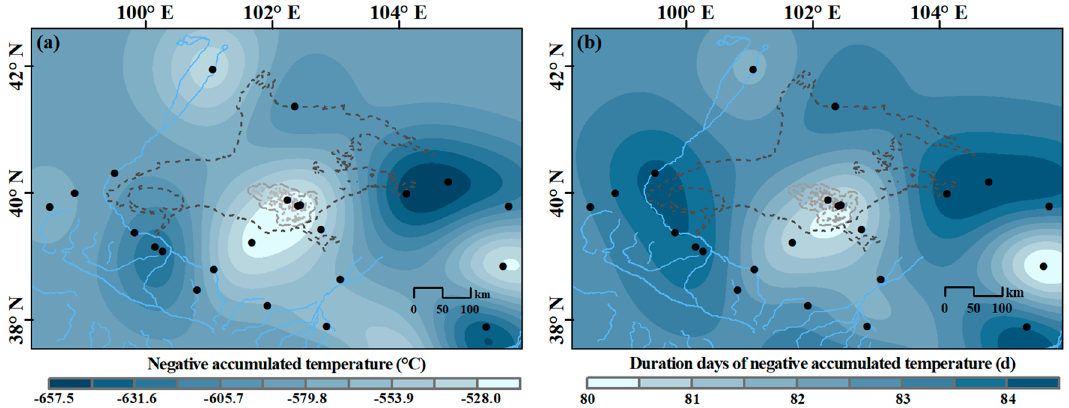
Figure 4. ( a ) Spatial distribution of negative accumulated temperature and ( b ) duration days from 2010 to 2017 over the BJD study area.